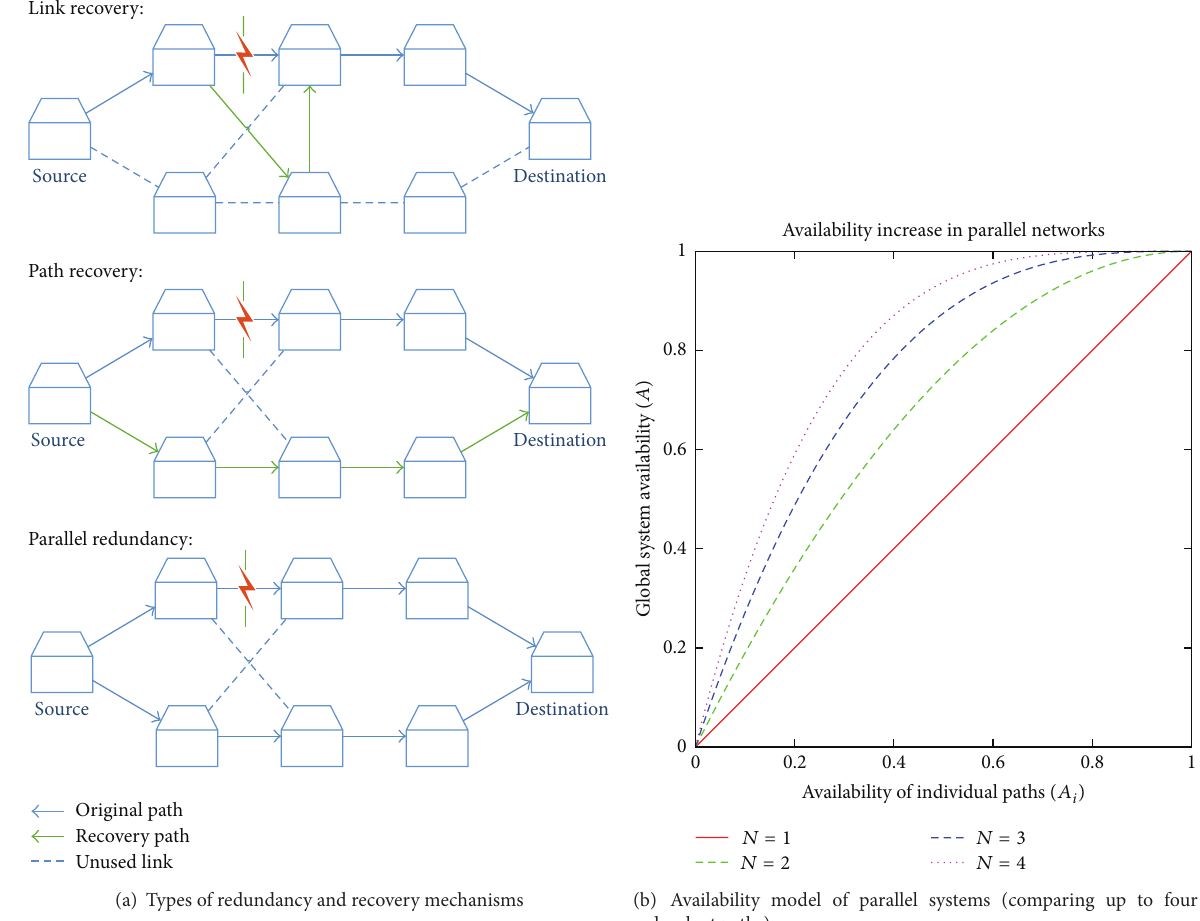
Figure 1: Relationship between redundancy and